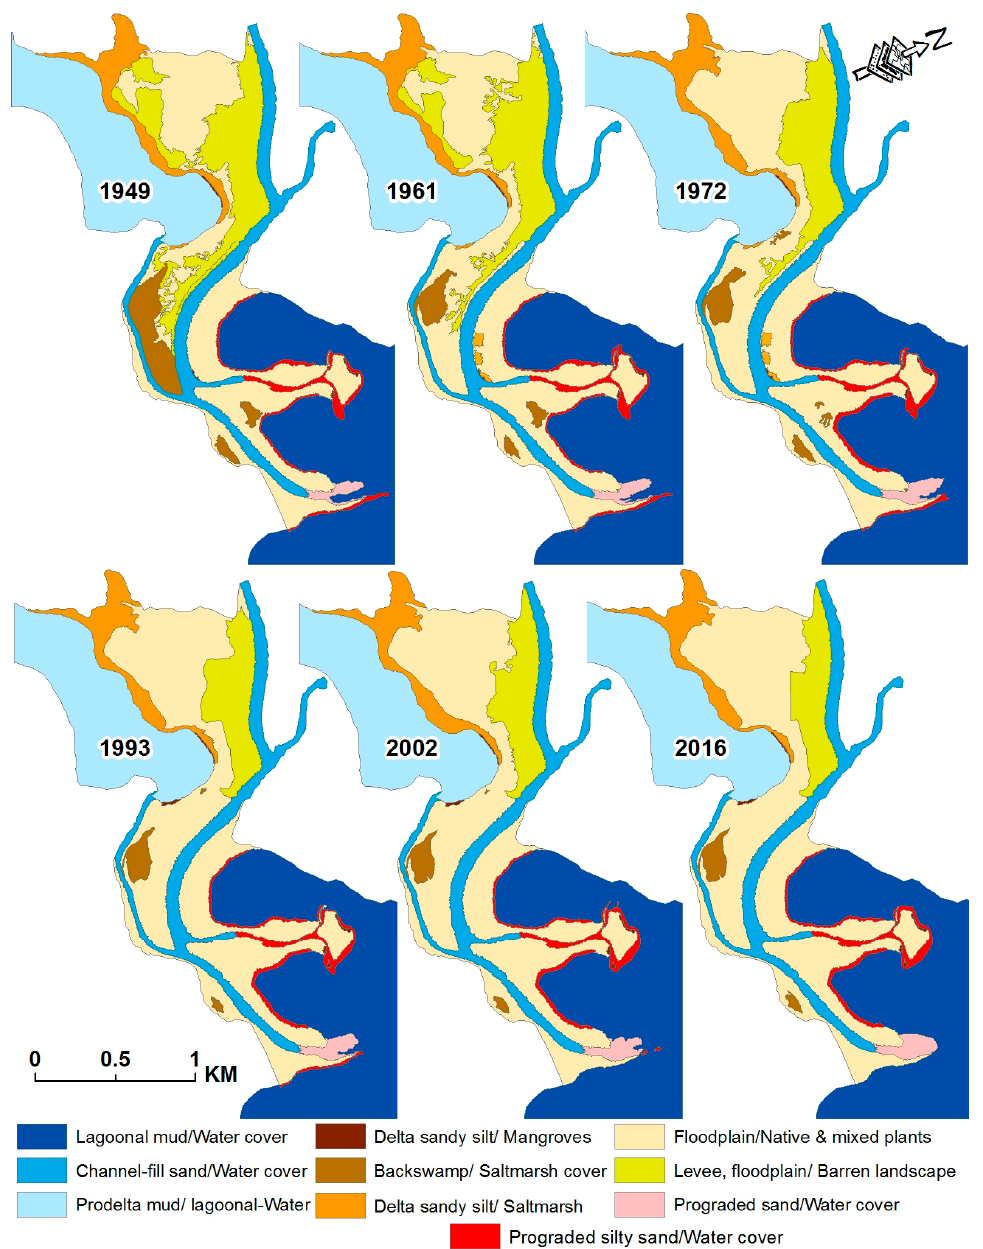
Figure 6. Multi-temporal high resolution aerial photograph classifications for 1949, 1961, 1972, 1993, 2002 and 2016 show progressive changes of Wandandian deltaic landform classes and shorelines. The clearest changes have occurred on the levee and backswamp facies where increasing native and mixed vegetation canopy indicates progressive eco-geomorphic stability. Prograded sand and silt bars have grown since 1949 and added more geomorphic accommodation habitat, thus allowing ecological development to continue.